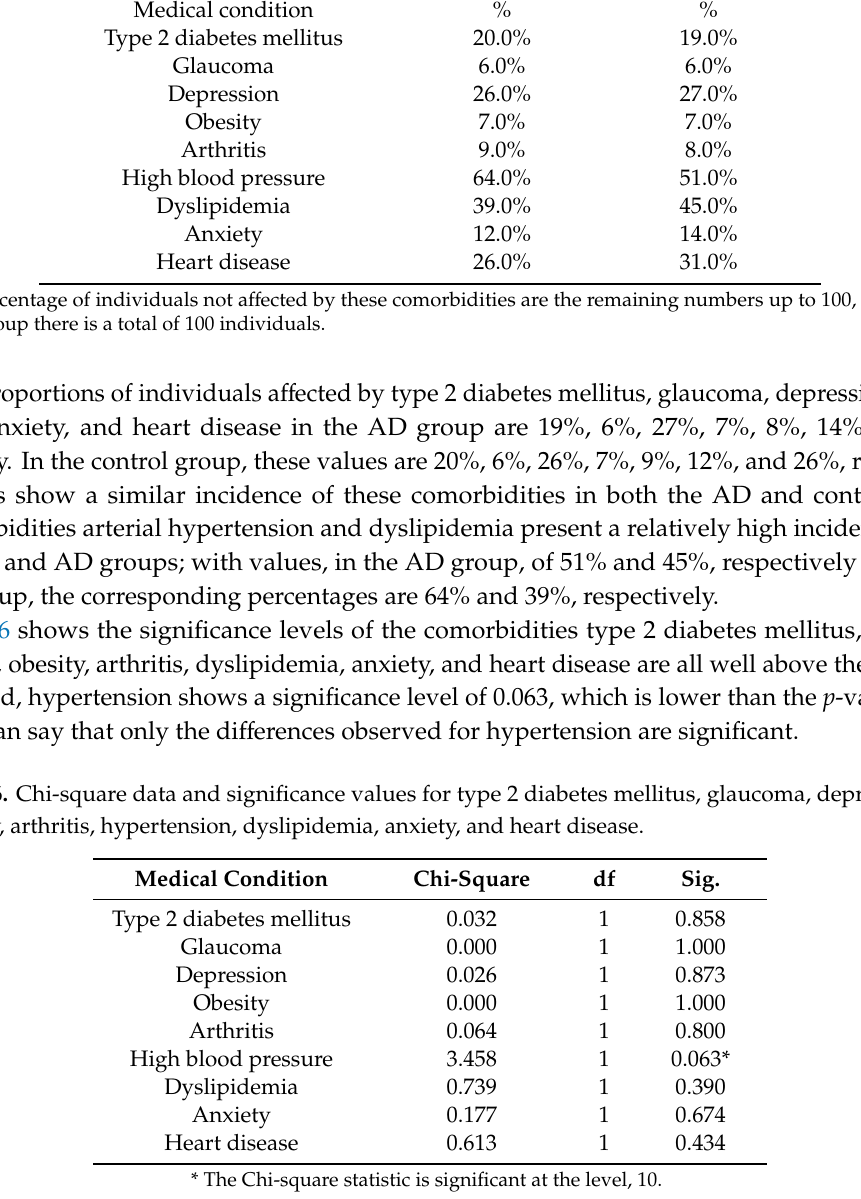
Table 5. Presence of comorbidities that do not show significant di ff erences in both groups. Control Group